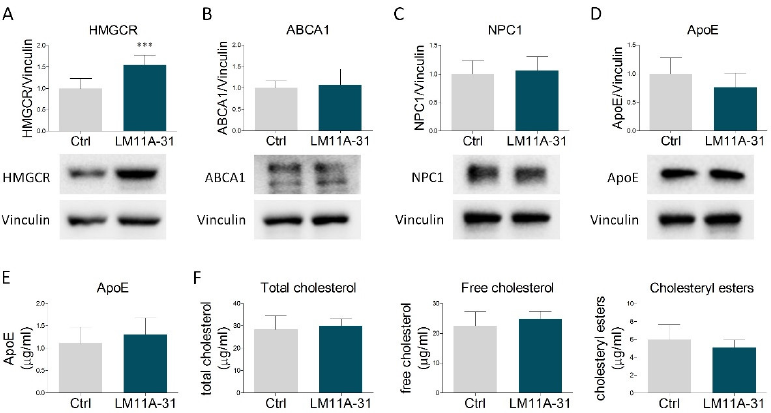
Figure 3. Effects of p75NTR modulation by LM11A-31 on cholesterol metabolism and secretion. ( A – D ) Representative Western blot and densitometric analysis of HMGCR, ABCA1, NPC1, and ApoE in U373 cells treated with vehicle (Ctrl) and LM11A-31 (0.1 µM) for 48 h. n = 4 different experiments. Vinculin served as a housekeeping protein to normalize protein loading. ( E ) Quantification of ApoE amount (µg/mL) by ELISA assay in culture medium from vehicle- and LM11A-31-treated U373 cells. n = 3 different experiments. ( F ) Cholesterol quantification (total cholesterol, free cholesterol, and cholesteryl esters) in the culture medium of U373 cells treated with vehicle (Ctrl) and LM11A-31 (0.1 µ M) for 48 h. n = 3 different experiments. Data represent means ± SD. Statistical analysis was carried out by using unpaired Student’s t test. *** p <